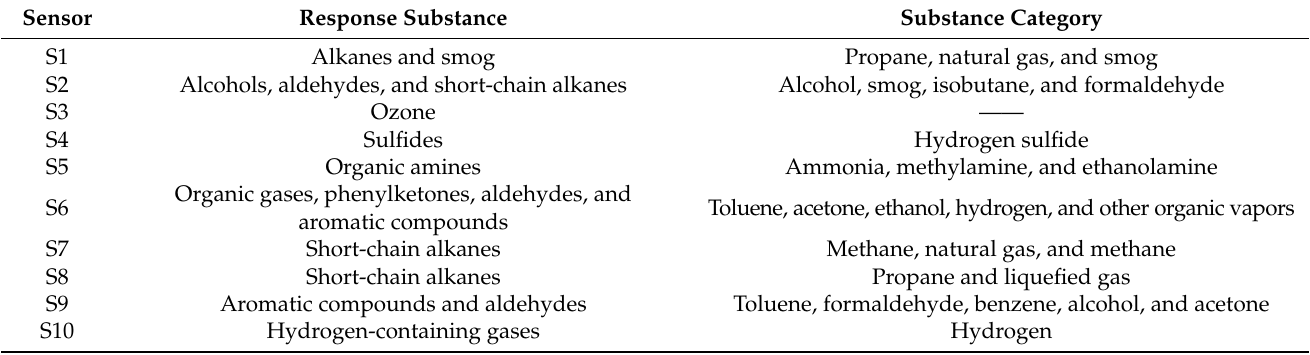
Table 1. Response substances and substance categories corresponding to the sensor